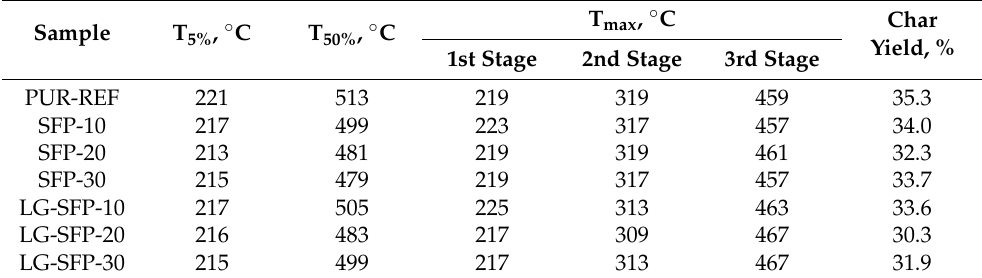
Table 5. Thermal degradation parameters of PUR-REF, SFP, and LG-SFP modified PUR foams.